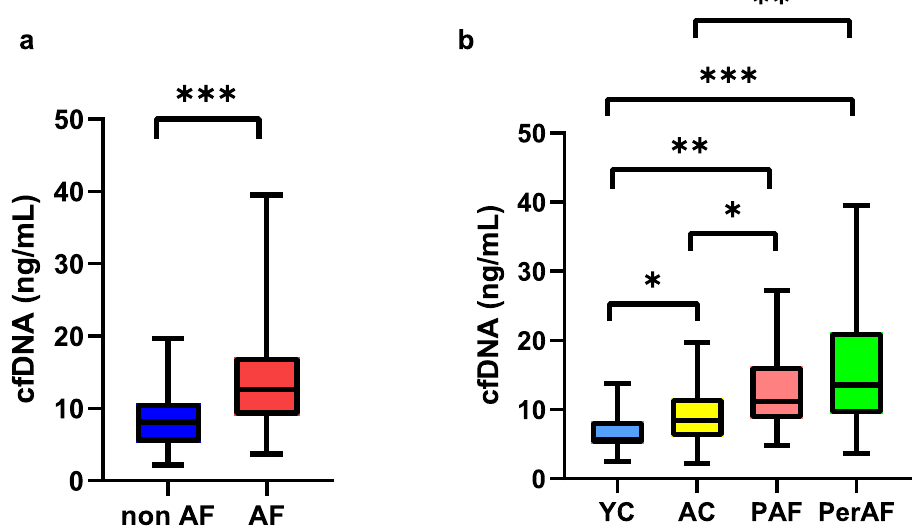
Figure 1. Elevation of total cfDNA in AF patients. ( a ) Comparison between non-AF and AF. ( b ) Comparison among the 4 subgroups. Mann–Whitney test was performed for a, Kruskal–Wallis test followed by post-hoc Steel–Dwass for b. * p < 0.05, ** p < 0.01, *** p <